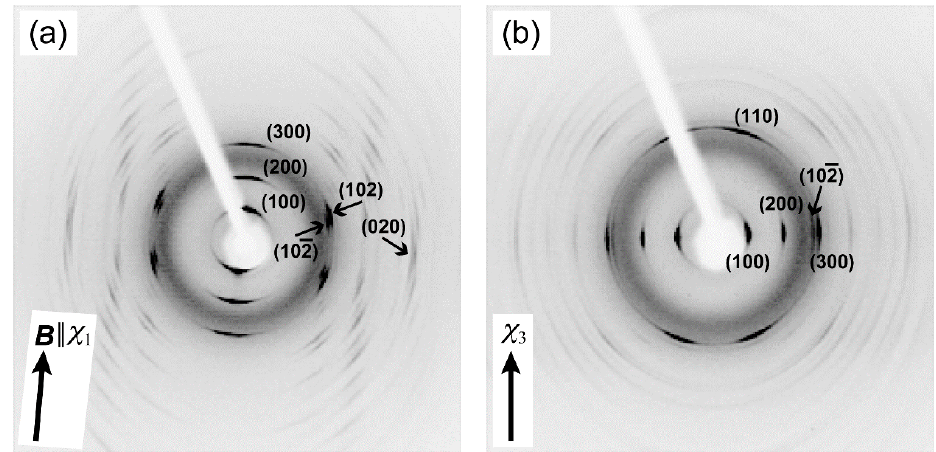
Figure 2. Two-dimensional wide-angle X-ray diffraction (2D-WAXD) patterns of one-dimensional magnetically oriented microcrystal arrays (1D-MOMAs) of PPAZn. ( a ) 1D-MOMA prepared under a static magnetic field (1Ds-MOMA), and ( b ) 1D-MOMA prepared under a rotating magnetic field (1Dr-MOMA). X-rays were impinged perpendicular to the χ 1 -axis and χ 3 -axis for ( a ) and ( b ), respectively.